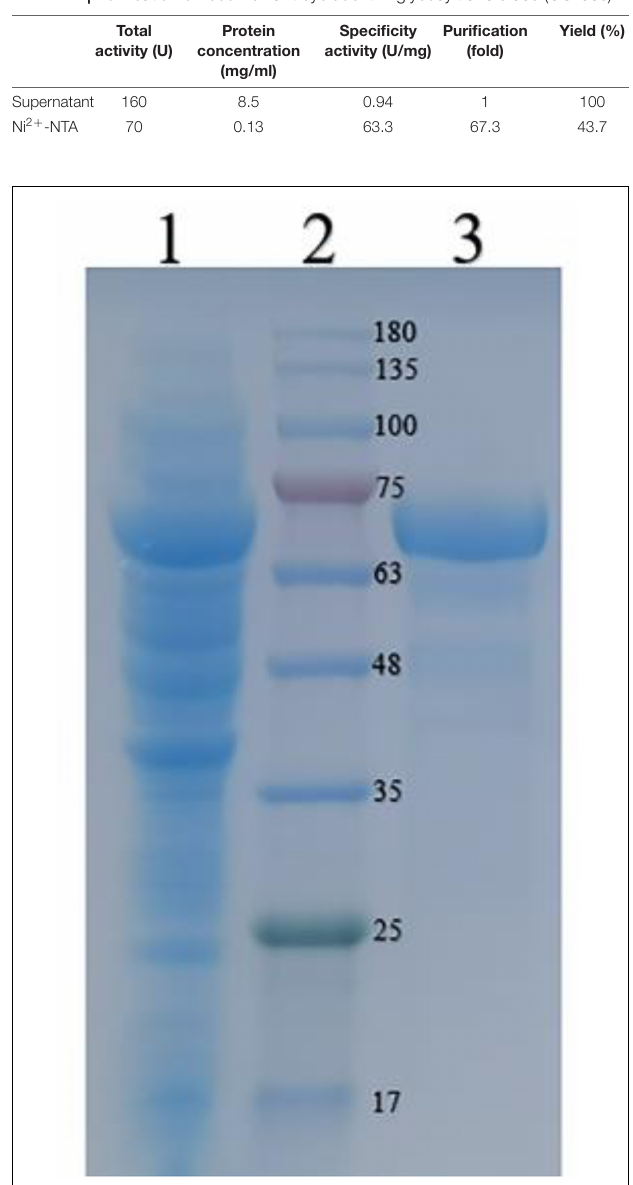
TABLE 1 | Purification of recombinant cyclodextrin glycosyltransferase (CGTase).